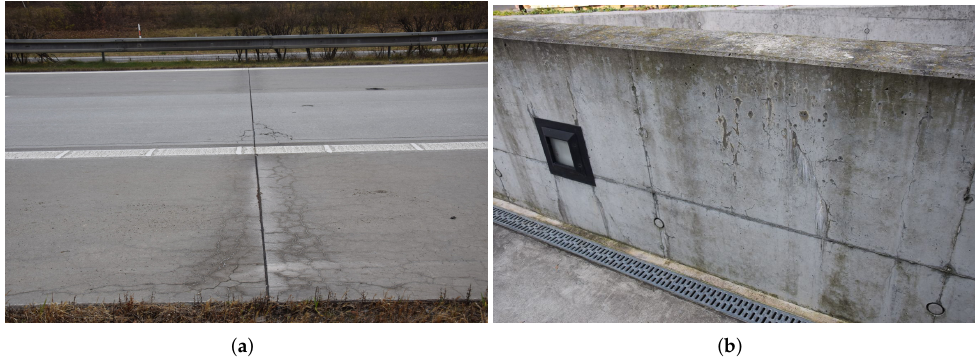
Figure 3. Cracks in a concrete pavement after 18 years ( a ) and in a parapet wall after 14 years ( b